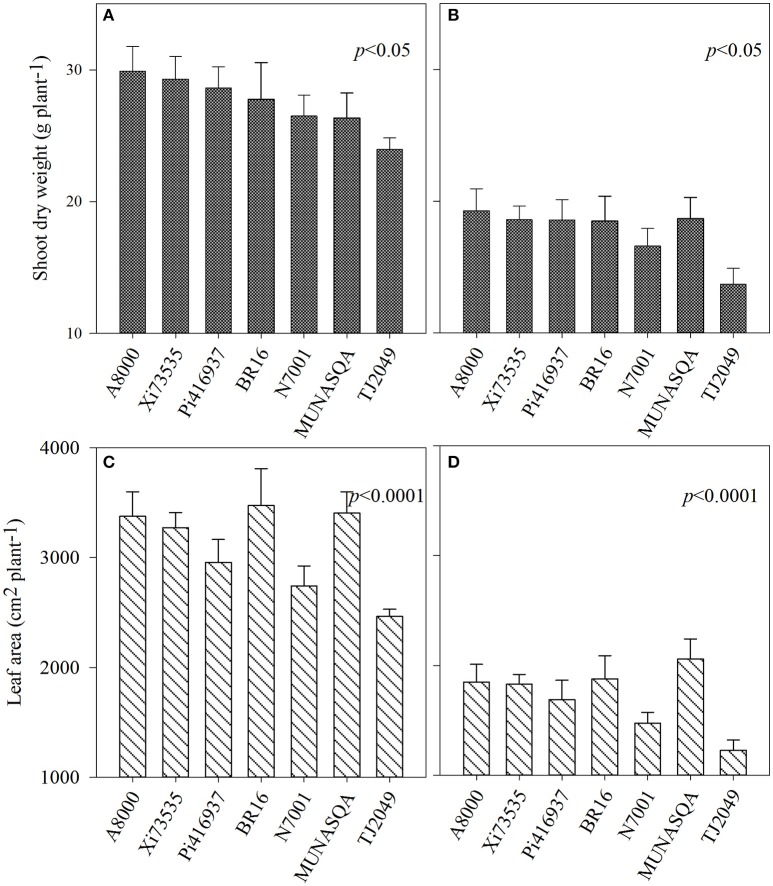
Shoot dry weight (A,B) and leaf area (C,D) at 57 days after emergence of the Experiment 1 for the seven soybean genotypes under well-watered (left) and water deficit conditions (right). Vertical bars represent mean values, error bars represent standard errors.